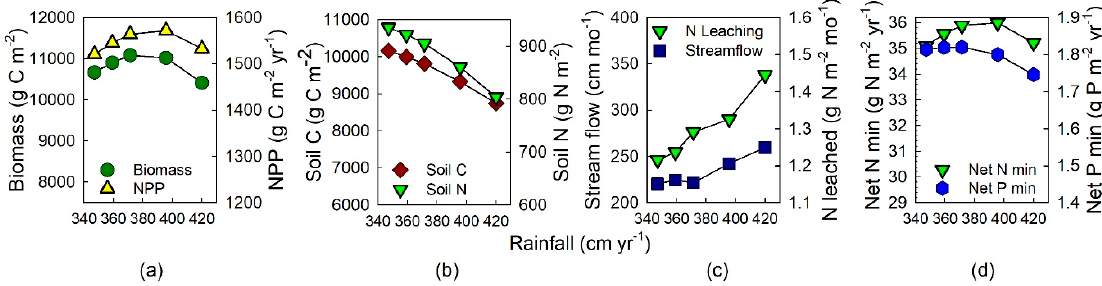
Figure 3. Model output from sensitivity analyses to evaluate effects of a decrease in rainfall during the drier season on ecosystem properties and processes: ( a ) Biomass C and aboveground NPP (ANPP); ( b ) soil C and N stocks; ( c ) streamflow and N leaching; ( d ) net N and P mineralization. Each datum within a graph represents the model output from a single run.